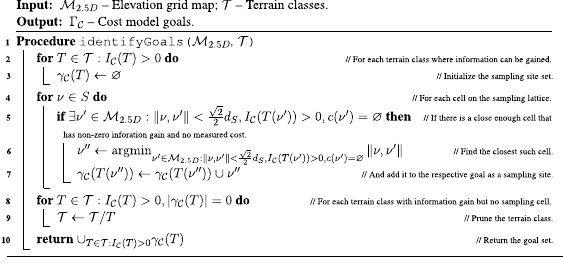
Algorithm 9. Identify goals.